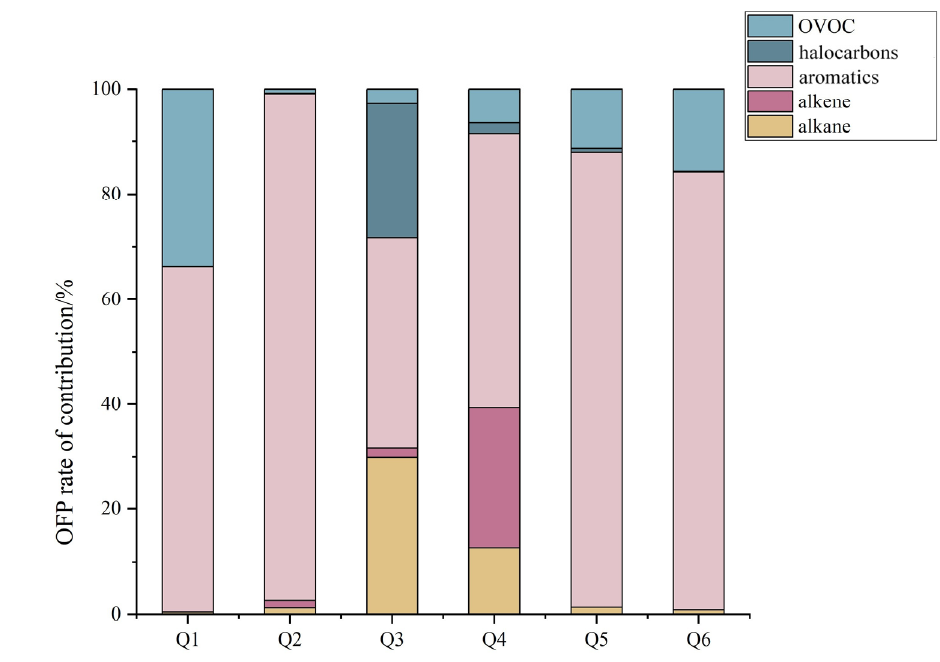
Figure 5. Percentage contribution of different components to OFP.